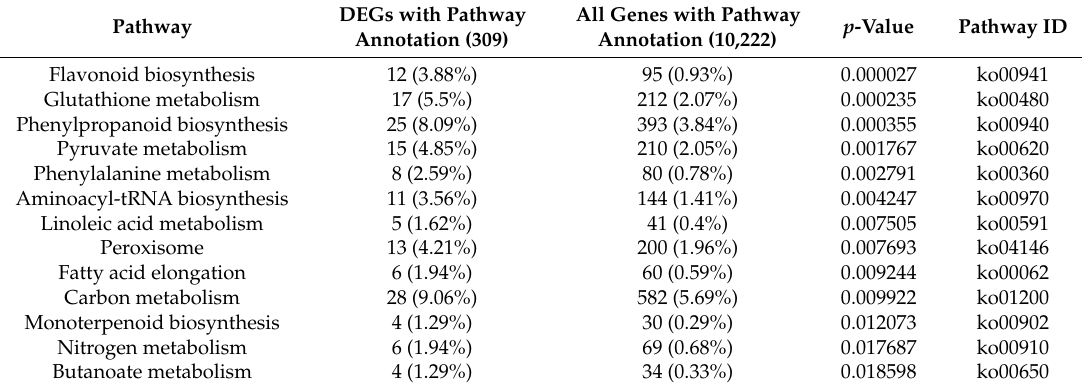
Table 2. KEGG pathway enrichment analysis of DEGs in “Granny Smith” apple skins ( p <